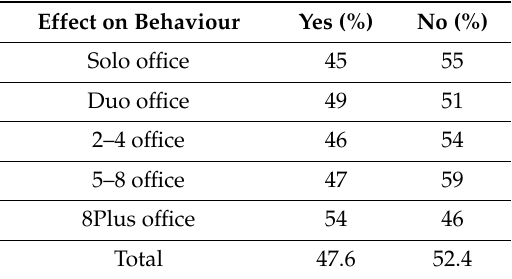
Table 3. Effect on